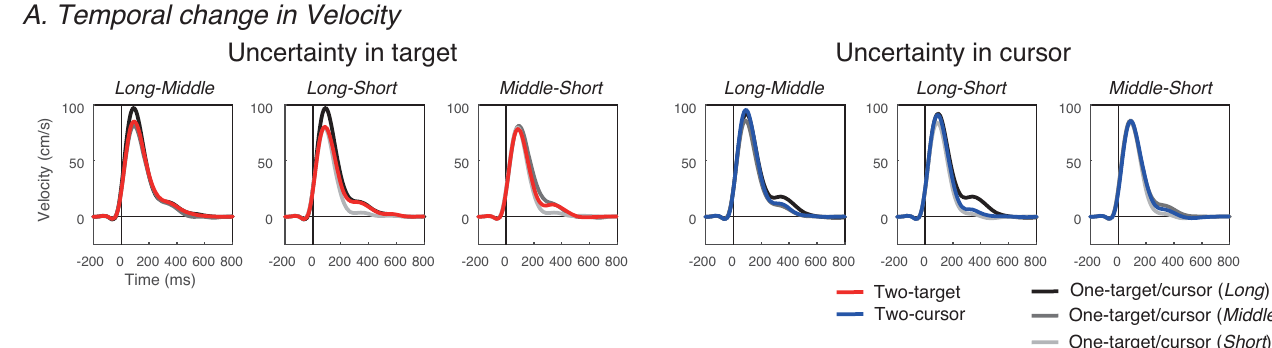
Fig 2. Temporal changes in velocity. Temporal changes in Velocity. These panels show the typical examples of the velocity profile as a function of time in the Long-Middle , Long-Short , and Middle-Short conditions in each two-potential condition. Red and blue lines show the two-potential conditions. Black, dark-gray, and light-gray lines show the profiles in the Long , Middle , and Short conditions in each one-potential condition corresponding to the presented distance conditions of the two-potential conditions in each panel. Consistently, as in this participant, velocity profiles with a large first peak were